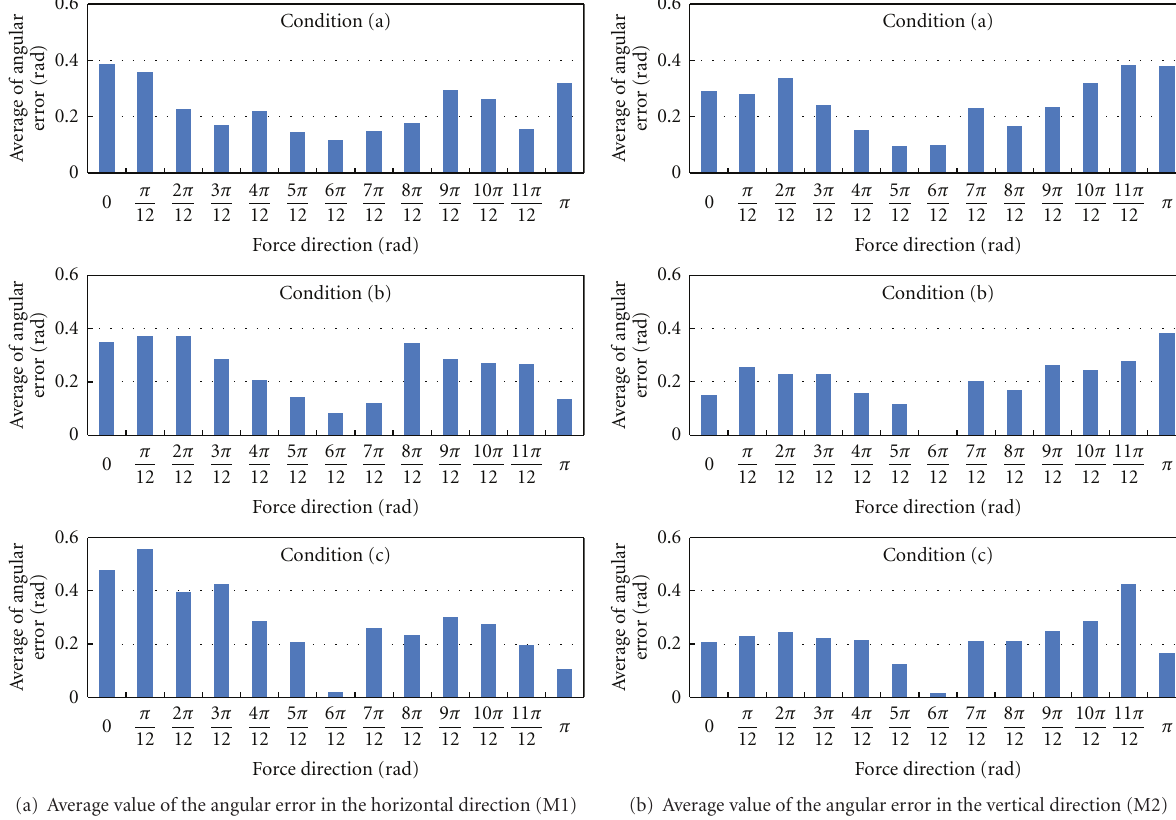
(b) Average value of the angular error in the vertical direction (M2) Figure 9: Measurement results of the angular error at each presented force direction.